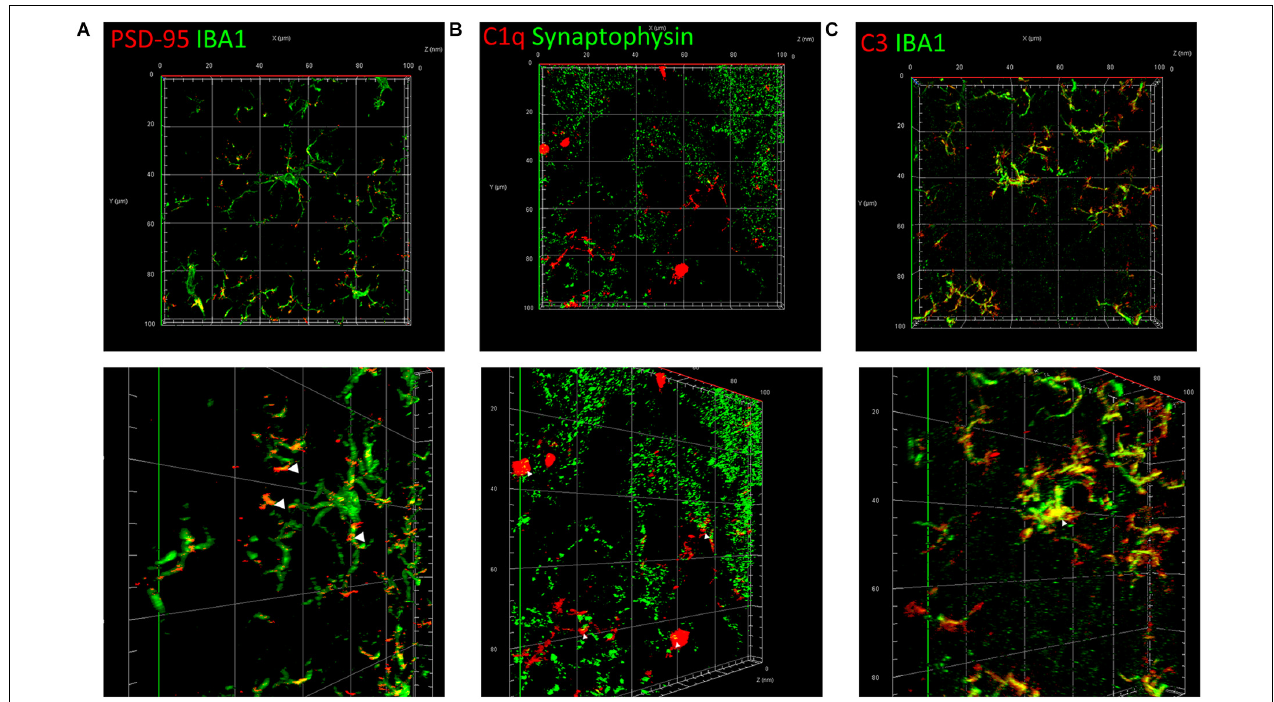
FIGURE 5 | Classical complements and microglia mediate the impairment and loss of synapses. (A) Immunostaining of IBA1, a specific microglia marker, and PSD-95, a postsynaptic marker. (B) Immunostaining of C1q and the presynaptic marker synaptophysin. (C) Immunostaining of IBA1 and C3. The picture in the lower row of each group is the shot of the corresponding three-dimension view after appropriate